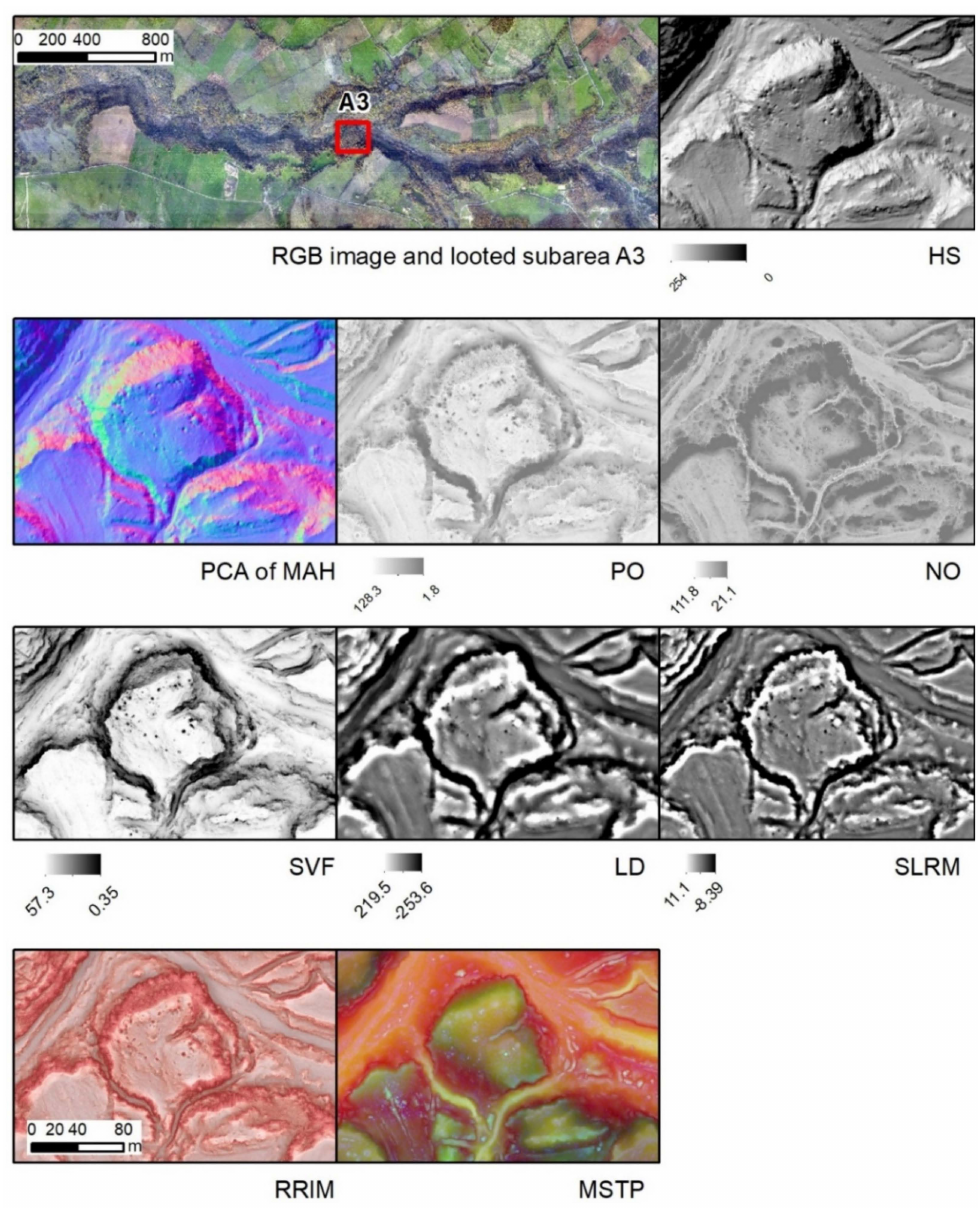
Figure 6. The subarea A3 found with VTs affected by looting. In the left-high corner, the localization of the A3 subarea is overlaid to the RGB image. In the other frames the different VT results are